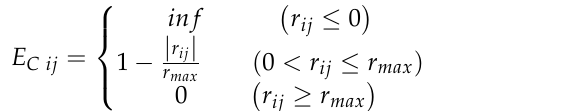
Figure 13. Rule-based speed profile generation. 5. Simulation 5.1. Simulation Statement Simulations are conducted with our hardware-in-loop (HIL) simulator, with the Lat- tice planning techniques in reference [4] as a control group. Parameters are shown in Table 1, and the simulation architecture is shown in Figure 14. Table 1. Simulation parameters. Item Model/Value Rapid Autopilot Controller